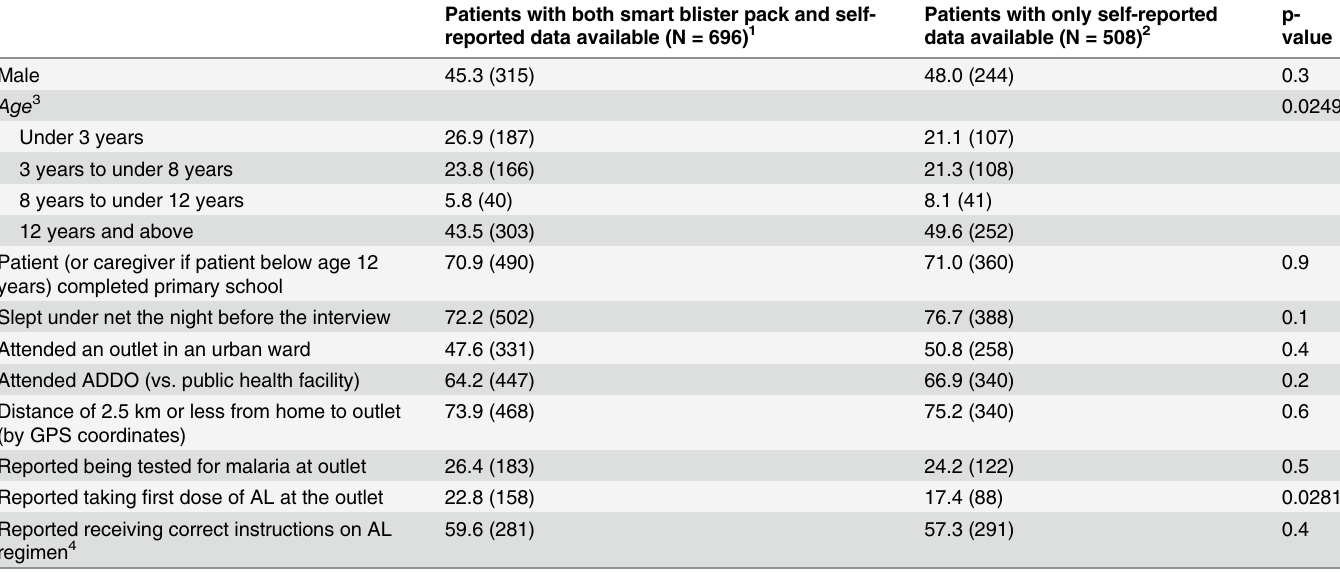
Table 1. Characteristics of patients with and without self-report and smart blister pack data available (percent (number)) 1,2